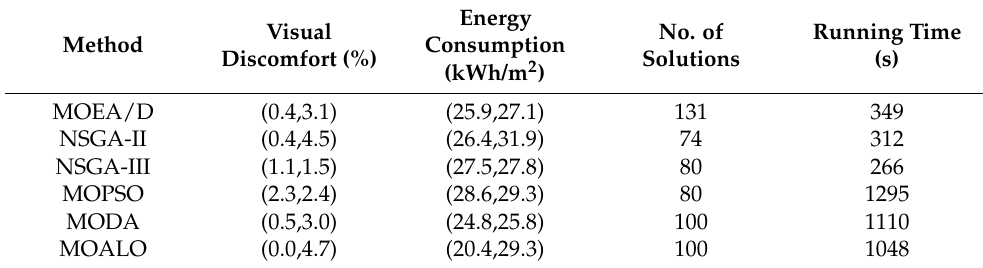
Table 8. Comparison of algorithm running results.